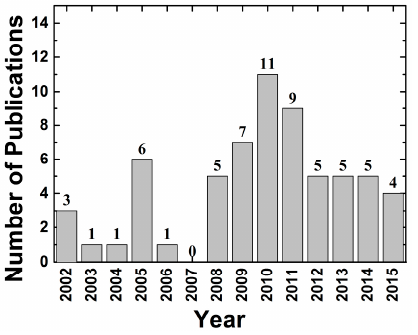
Figure 2. Number of publications related to bioleaching over time. This graph is based on publications presented in the Korean Journal Database (Thomson Reuters ISI Web of Science).